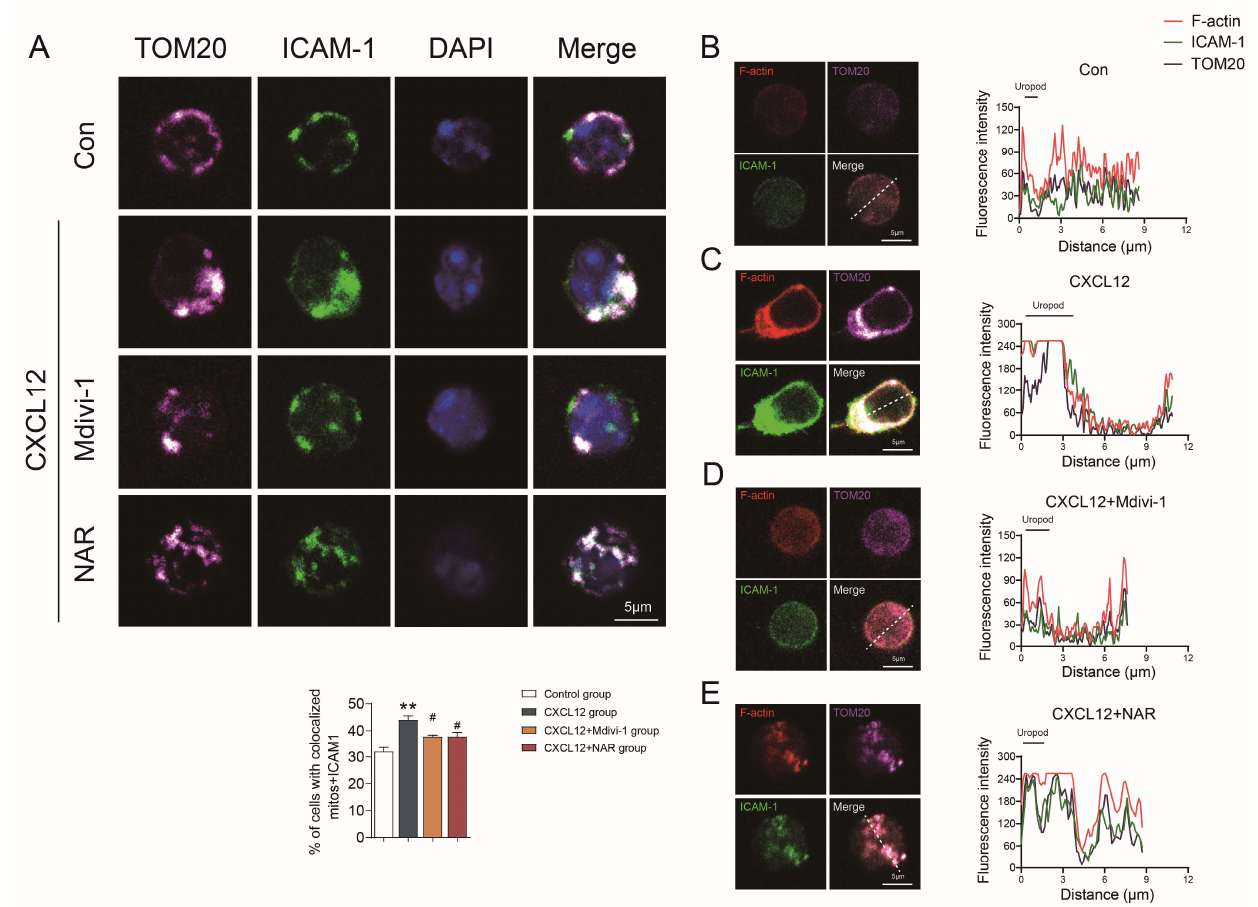
Figure 7. NAR inhibited the mitochondrial distribution and migration of primary CD4 + T lympho- cytes. ( A ) Mitochondria (TOM20) and the uropod marker ICAM1 in different groups. The percentage of cells with co-localized mitochondria and ICAM1 is reported in the graph (n = 3 mice per group). Control group ( B ), CXCL12 group ( C ), CXCL12 + Mdivi-1 ( D ), CXCL12 + NAR ( E ) CD4 + T lympho- cytes were stained for the indicated proteins (F-actin (detected using fluorescent phalloidin); ICAM-1; and TOM20) and (left) imaged by confocal microscopy; the uropod is marked with ICAM-1. (Right) Fluorescence intensity analysis was performed from the uropod to the leading edge (L.E.) over the line represented at the merge image. ** p < 0.01 vs. control group, # p < 0.05 vs. CXCL12 group, by repeated-measures one-way ANOVA followed by post hoc Dunnett’s multiple comparisons test. All scale bars are 5 µ m. The data are presented as means ± SEM (n = 3 mice per